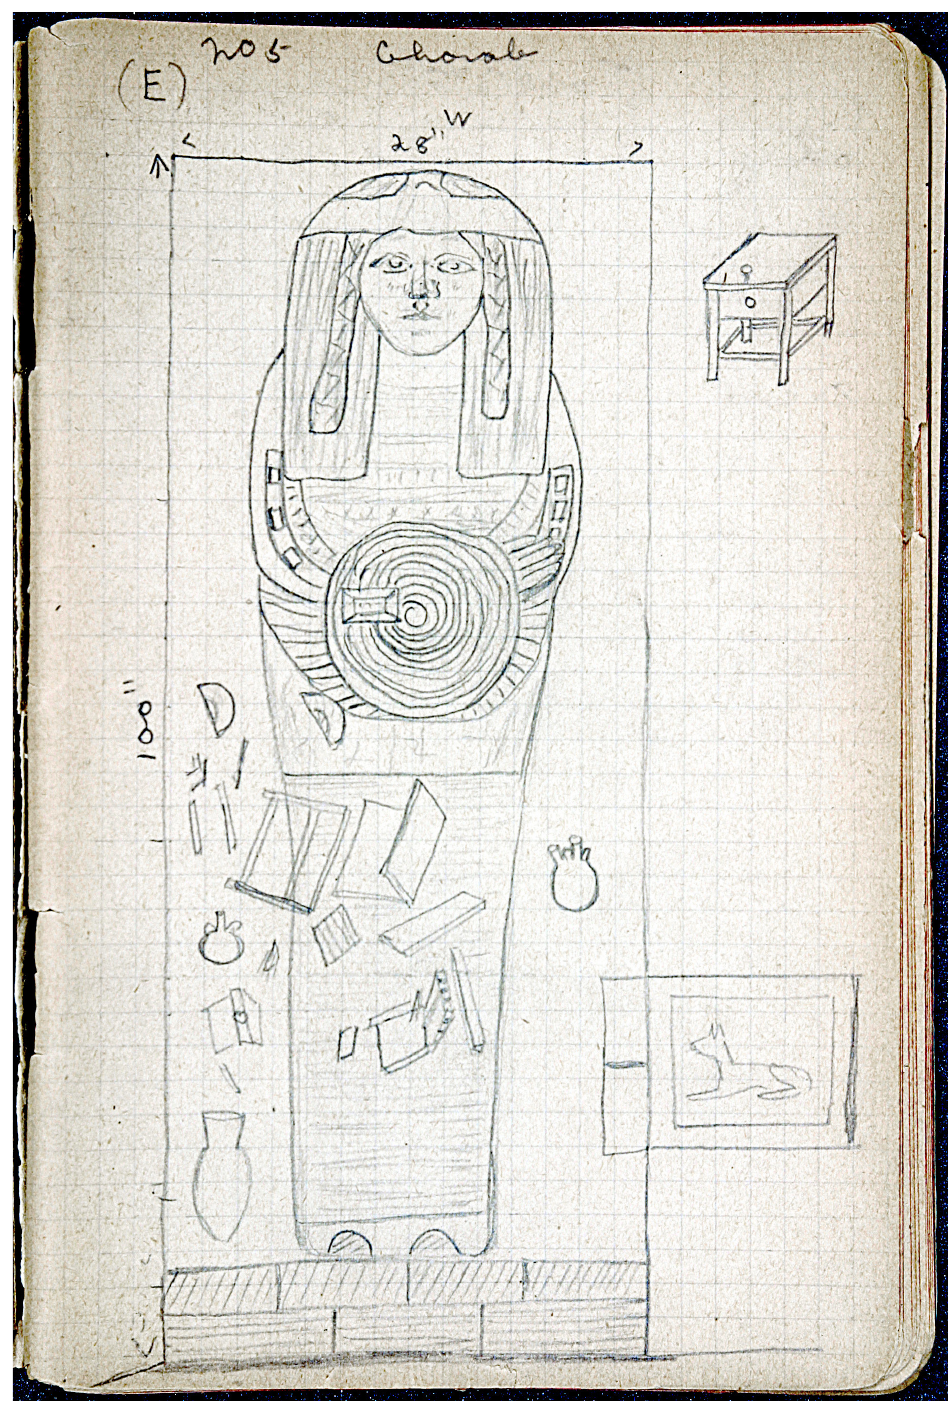
Fig. 2: Drawing of in situ burial, Grave 705, Gurob, from the unpublished field notebook 34a in the Petrie Museum